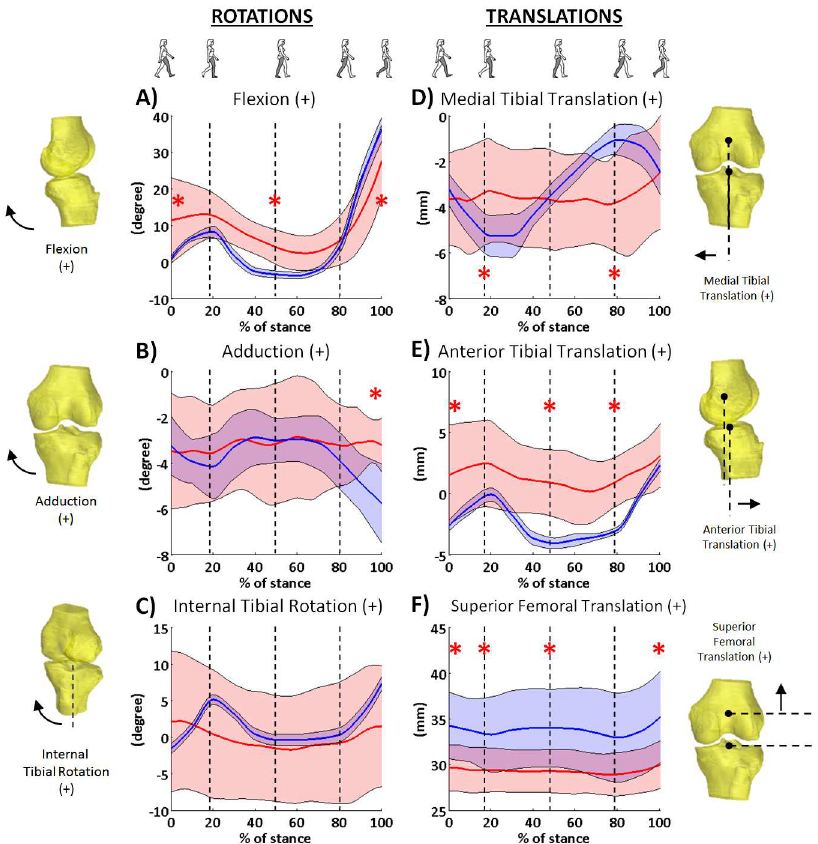
Fig 3. Six degree-of-freedom kinematics during stance phase of treadmill gait in obese individuals with knee pain (red. S1 File) and a healthy population (blue, data previously published in Kozanek et al. J Biomech. 2009;42(12):1877–1884.). Solid line indicatesthe mean and shade area for ± 1SD. Asterisk denotessignificantdifference betweentwo